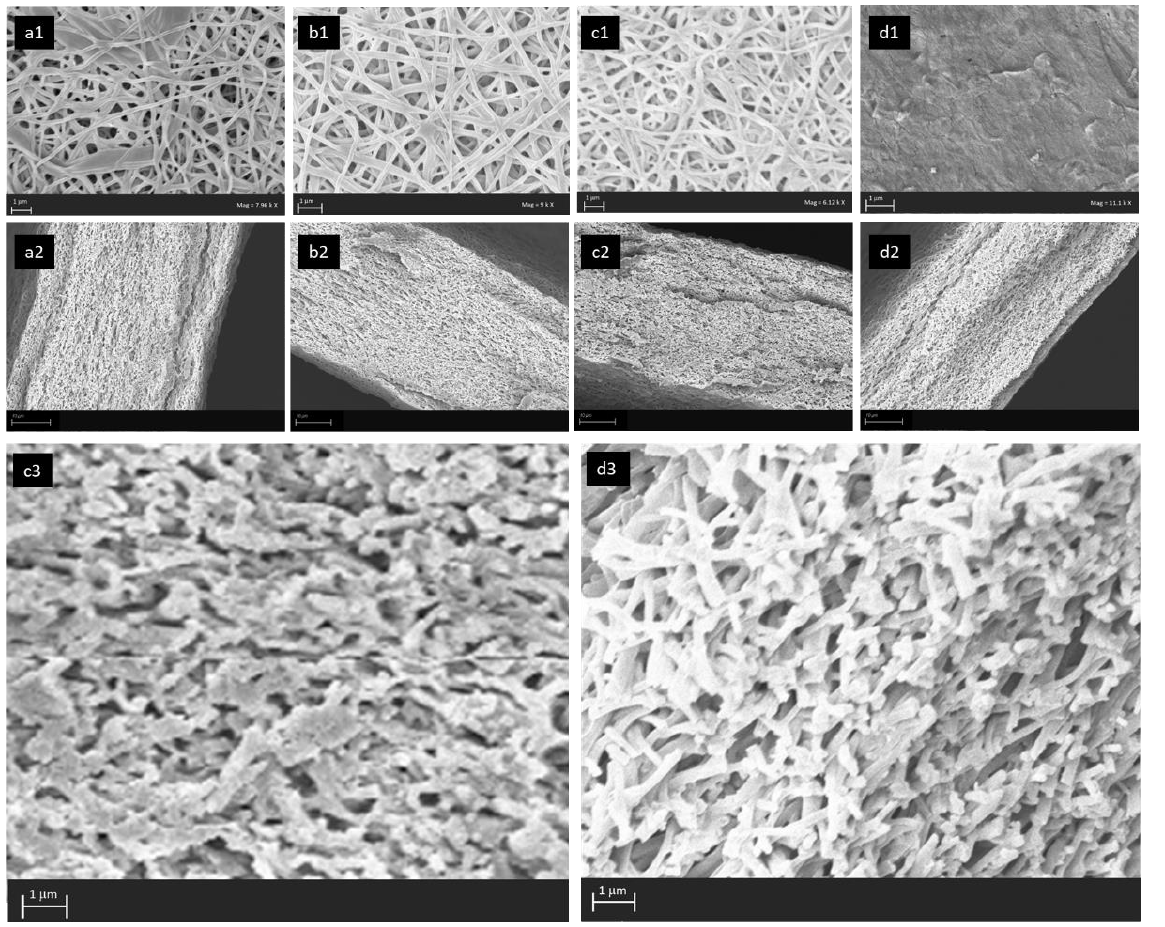
Figure 6. SEM images of surface morphology (no. 1) and cross-section (no. 2 and 3) of ( a ) eQP-PDD 0.1 , ( b ) eQP-PDD 0.3 , ( c ) eQP-PDD 0.5 , and ( d ) eQP-PDD 1.0.